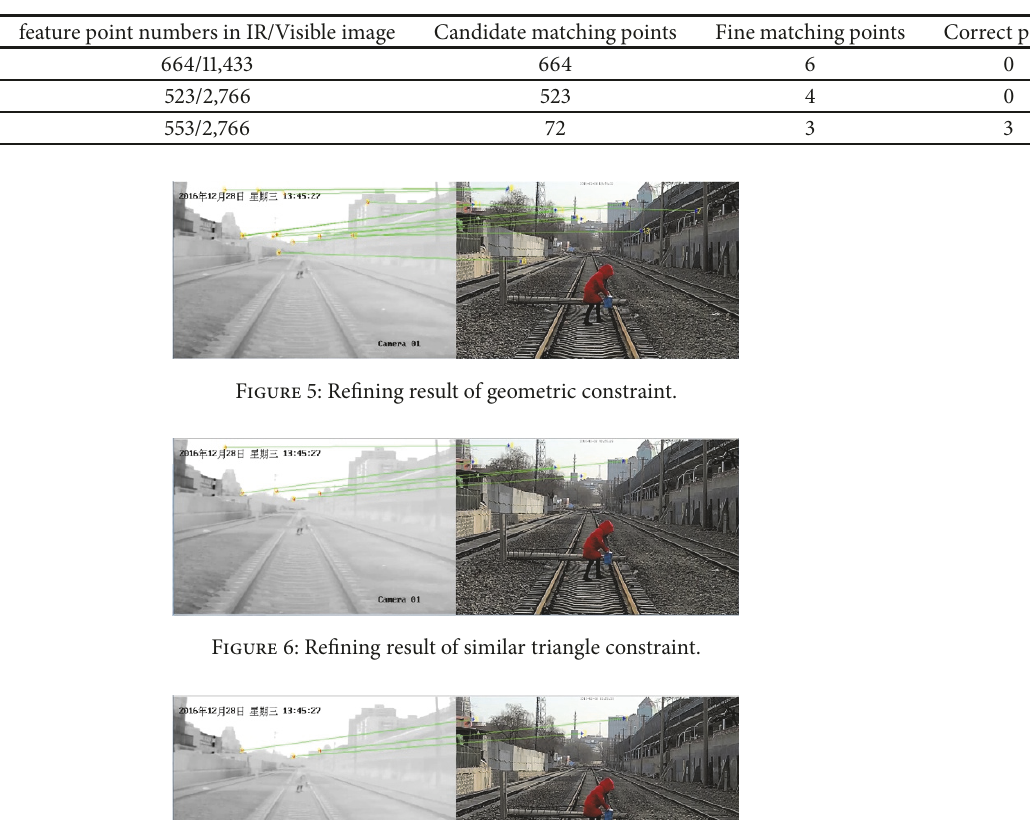
Table 1: Comparison of different matching algorithms.